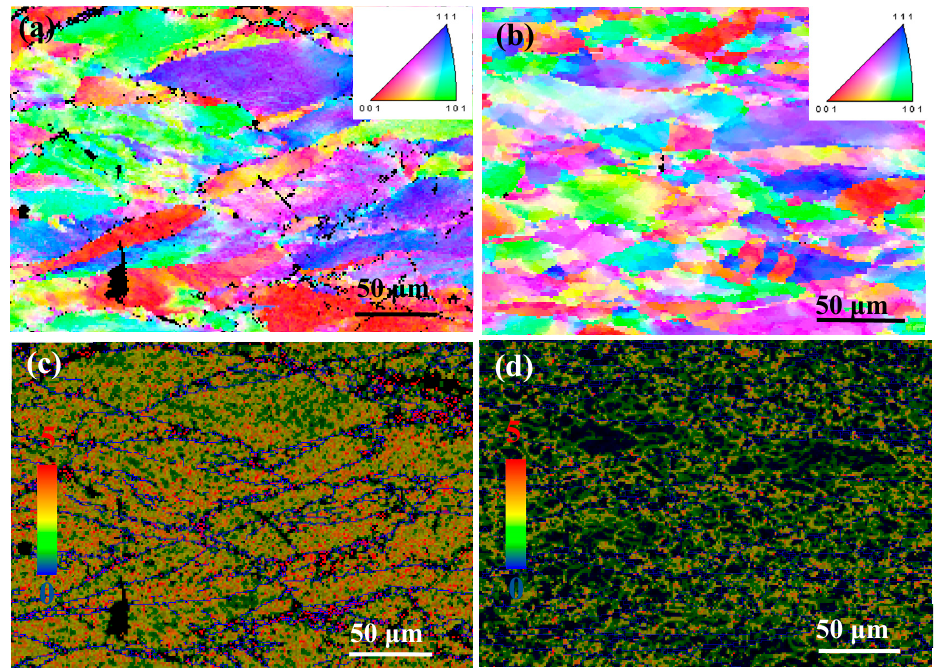
Figure 4. EBSD micrographs and Kernel Average Misorientation of the Cu-Ni-Co-Si-Cr alloy deformed at: ( a ) and ( c ) 600 °C and 0.001 s − 1 , ( b ) and ( d ) 900 °C and 0.001 s − 1 .